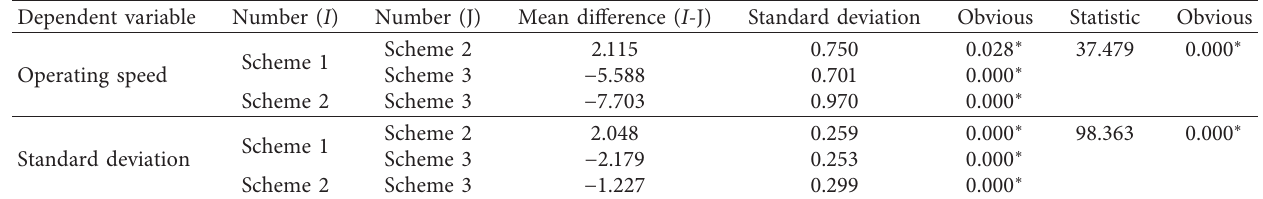
Table 5: Analysis of variance and multiple test results afterwards.